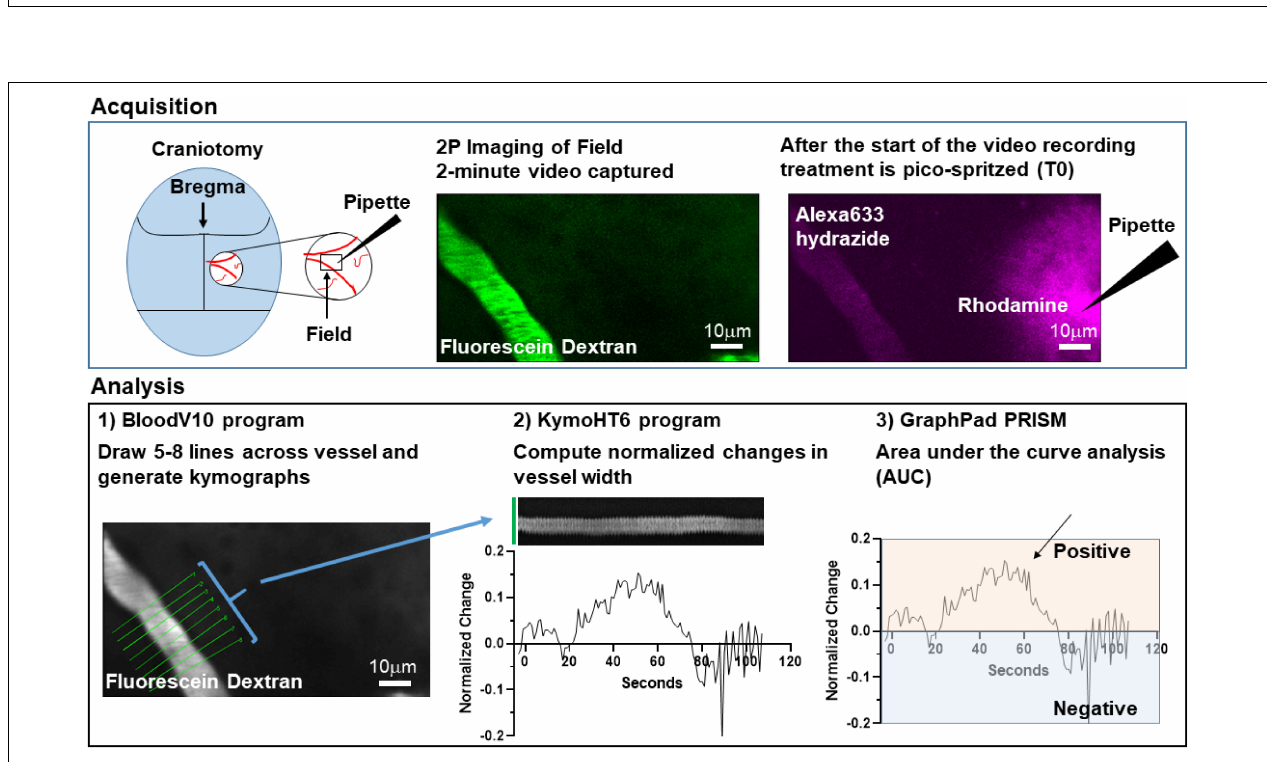
FIGURE 2 | Hypothesized mechanism for glutamate transport-dependent vasodilation. After neuronal depolarization, most of the glutamate released into the extracellular space is cleared by the astrocytic glutamate transporters, GLT-1 and GLAST. Several groups have shown that the simultaneous influx of Na + that drives glutamate uptake can trigger reversed operation of the Na + /Ca 2 + exchangers and increase in cytosolic Ca 2 + . This Ca 2 + can activate nitric oxide synthetase (NOS), phospholipase 2 (which generates arachidonic acid and can activate cyclooxygenase, Cox1 and Cox2), or other Ca 2 + -activated processes. These pathways have been linked to vasodilation in several studies (for references, see results). The pharmacologic agents used to test each of these targets is also included.